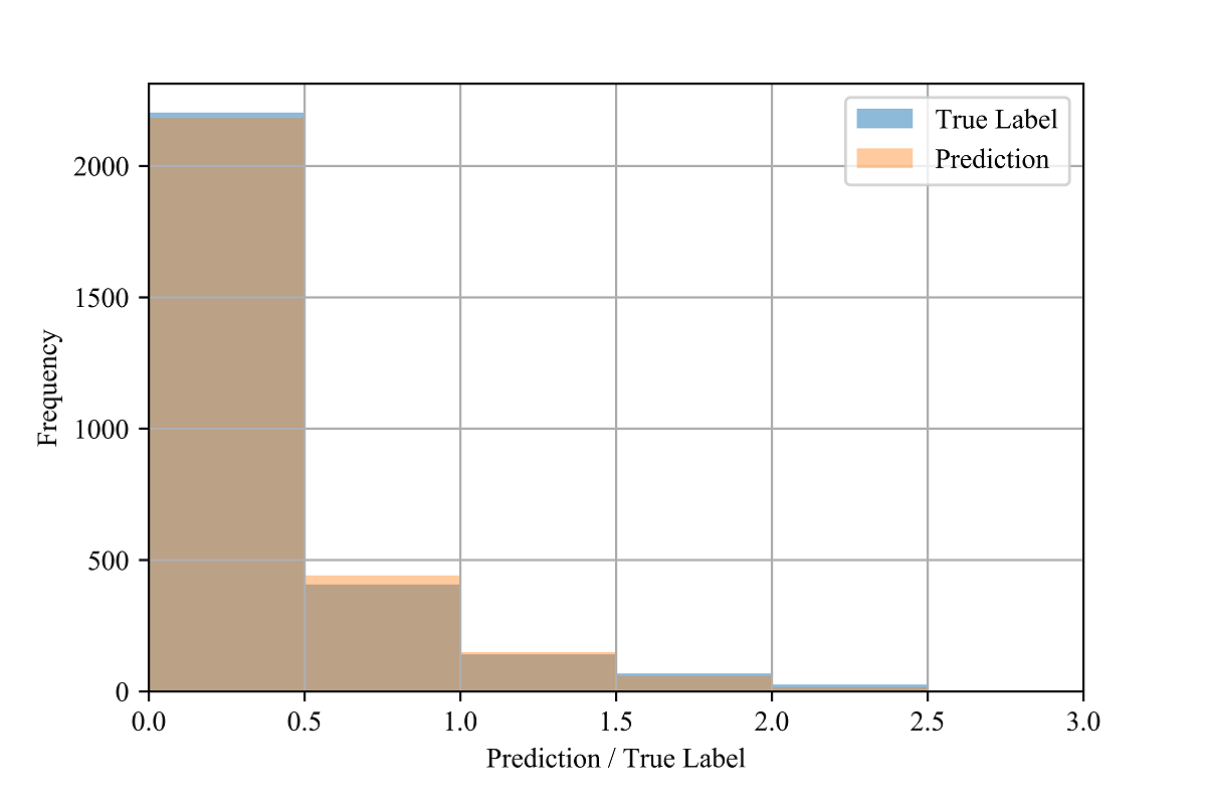
Figure 5. Distributions of the test labels (ie, true confirmed infection growth) and model predictions (n=2847) for the in-distribution method.